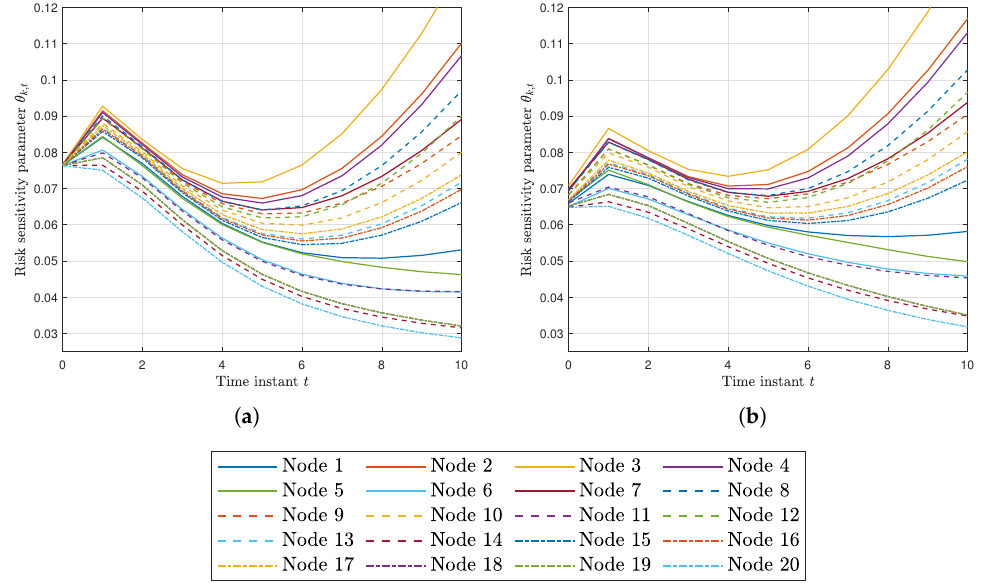
Figure 10. ( a ) Risk sensitivity parameter for each node using RKFDNU with tolerance c = 0.02. ( b ) Risk sensitivity parameter for each node using RKFDNU2 with tolerance c =